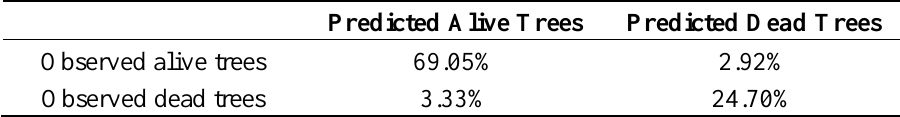
Table 10. Mean validation percentage using the parameters values selected for the LIDAR calibration and validation